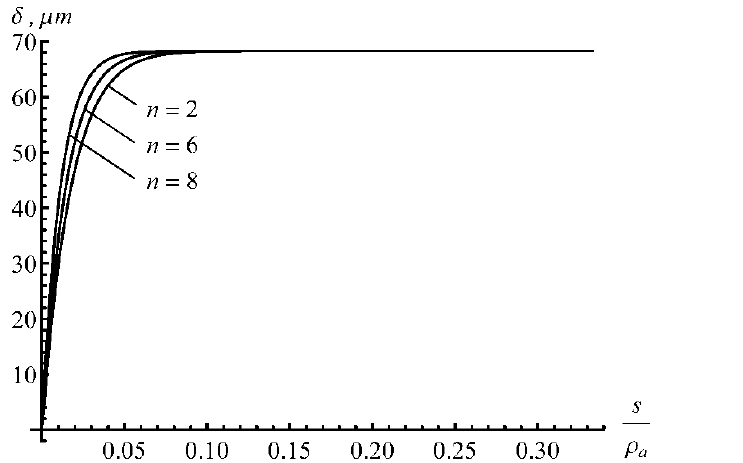
Figure 8. Thickness of the layer of intensive plastic deformation along the friction surface at θ 0 = 15 o and different n − values.